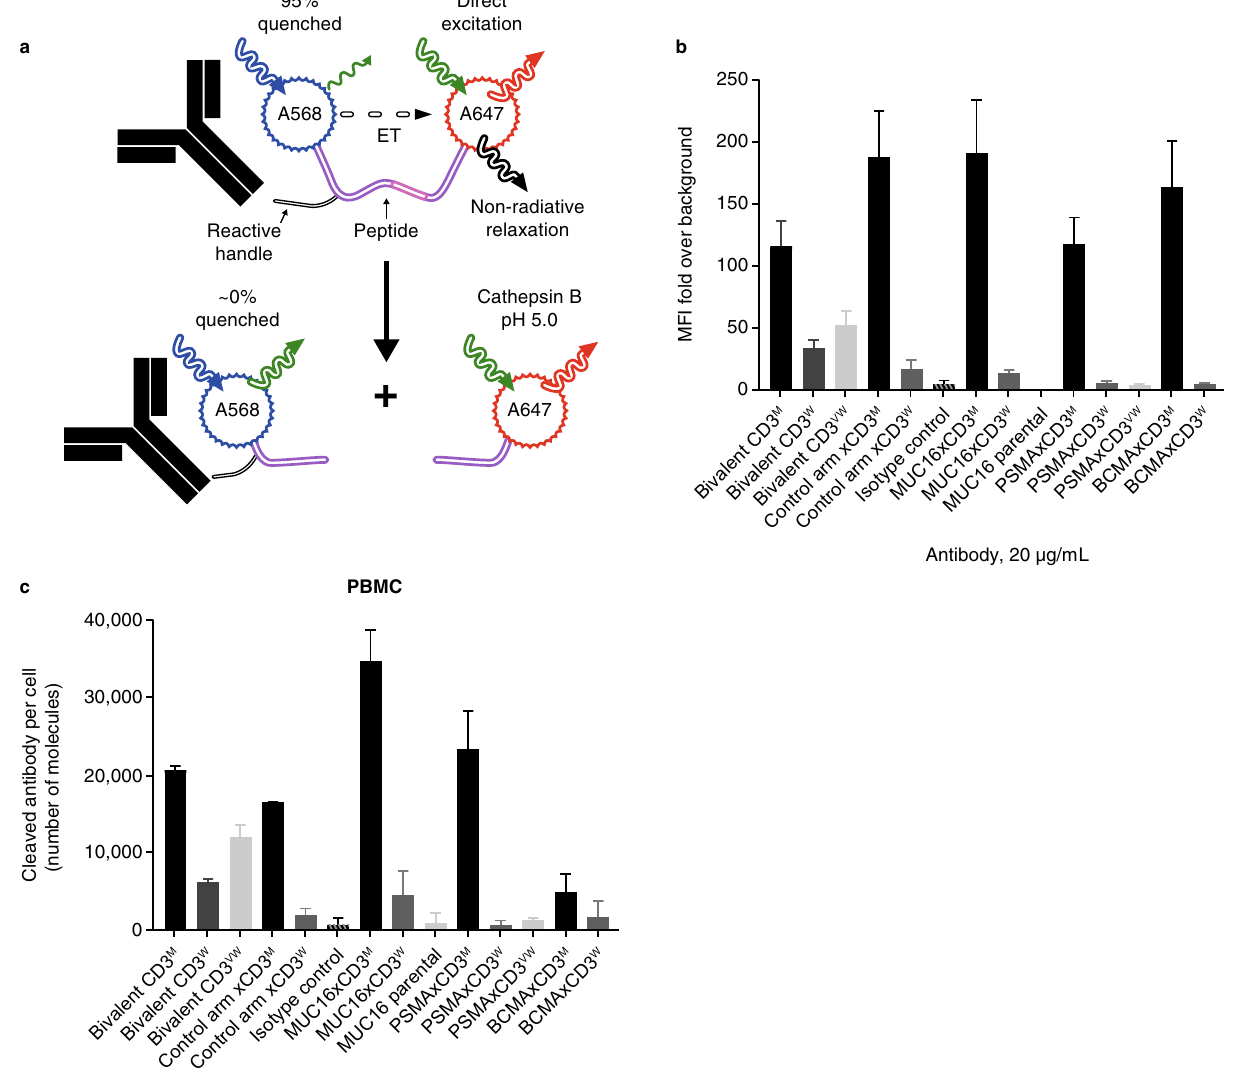
Figure 2. In vitro internalization by biosensor quantification. Antibodies were conjugated to a A647/568 biosensor. The biosensor molecule is composed of two fluorophores, A568 and A647, separated by a cleavable linker; when the molecule is intact, the A568 fluorophore is quenched by the A647 fluorophore ( a ), and binding (n = 2) of the conjugated antibody on the surface of a cell can be detected by flow cytometry using the A647 fluorophore ( b ). Upon internalization, the cleavable linker is cleaved by the lysosomal cysteine protease cathepsin B, and the remaining cleaved antibody can be detected by flow cytometry inside the cell for internalization measurement using the A568 fluorophore. PBMCs ( c ) were incubated with antibody biosensor conjugates for 18 h, stained with viability dye, and read in A568 channel by flow cytometry. The number of internalized and cleaved antibodies per cell in PBMCs was extrapolated from a A568-labeled beads standard curve (two replicates). (CD3 M arm shown in black , CD3 W arm shown in dark gray , CD3 VW arm shown in gray , Isotype control shown in gray striped ). BCMA B-cell maturation antigen; ET energy transfer; m moderate; MUC16 Mucin-16 for ovarian cancer; PBMC peripheral blood mononuclear cell; PSMA prostate specific membrane antigen; vw very weak; w